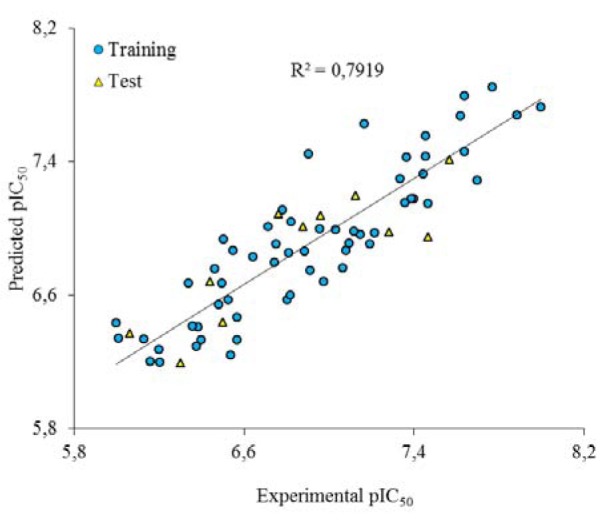
The predicted pIC50 values by the GA-MLR modeling vs. the experimental pIC50 values